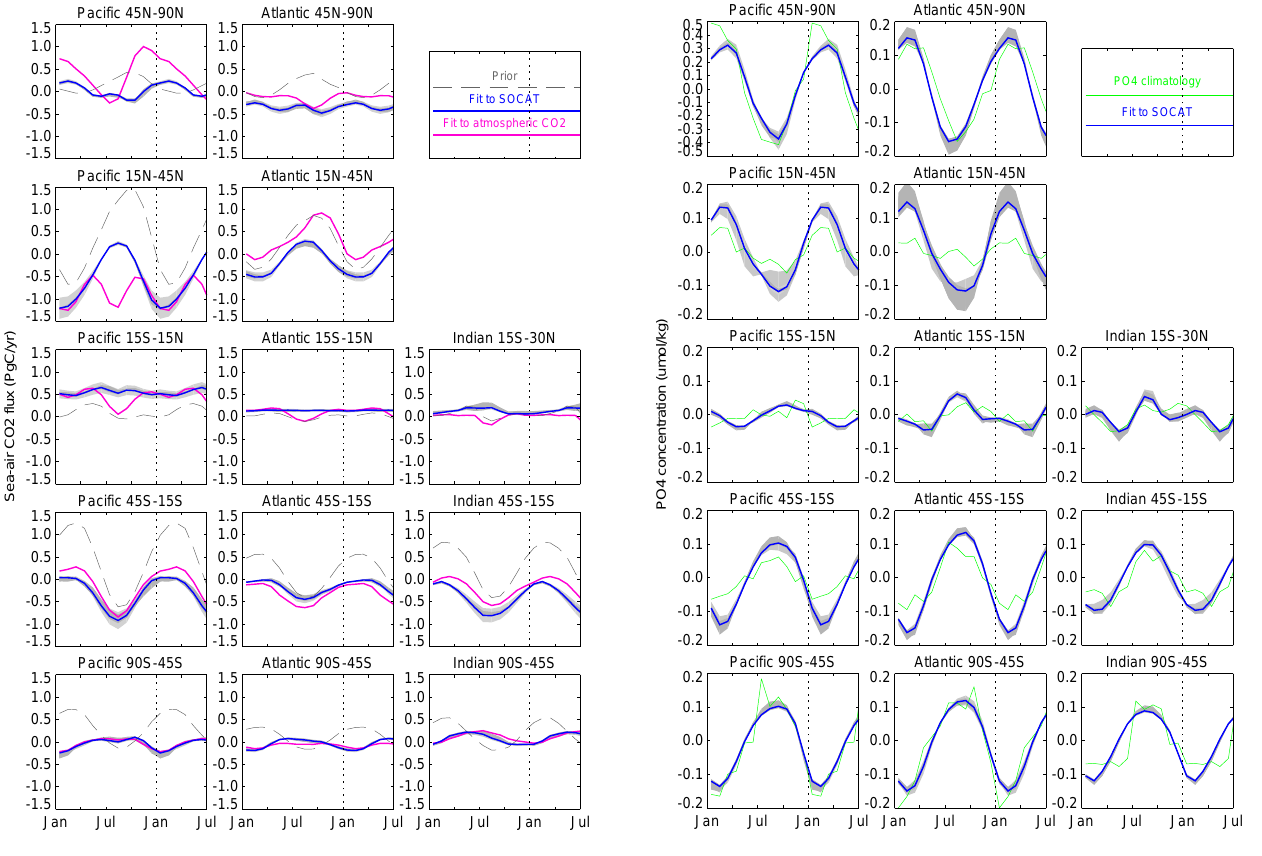
Fig. 11. Monthly mean seasonal cycle of sea–air CO 2 fluxes as Fig. 6. Estimates by fitting the diagnostic scheme to SOCAT data (run SFC , blue) are compared to the fit of the scheme to atmospheric CO 2 mixing ratio data (run ATM , magenta), as well as to the prior (no data constraint, thin dashed gray).